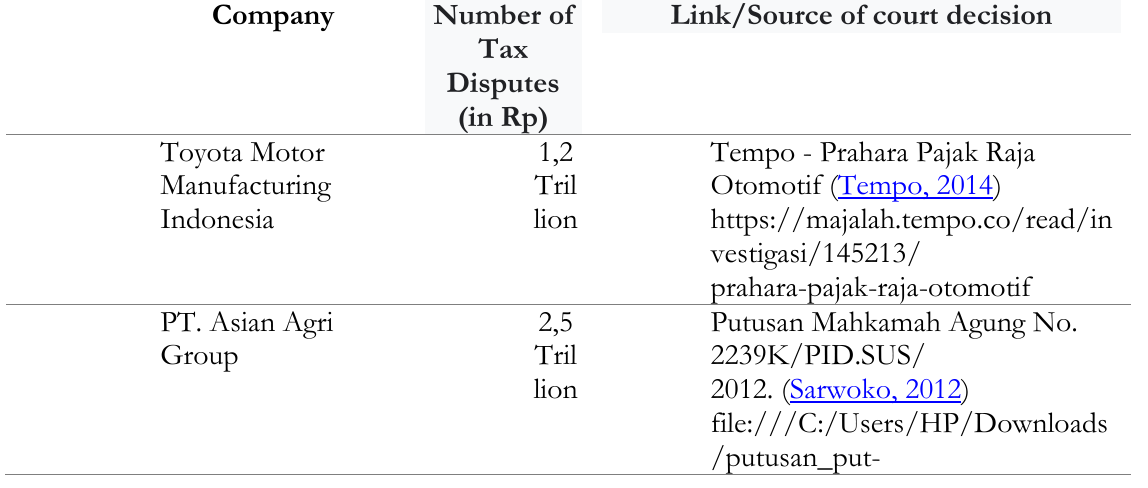
Tabel 2. Cases of Transfer Pricing Practices in